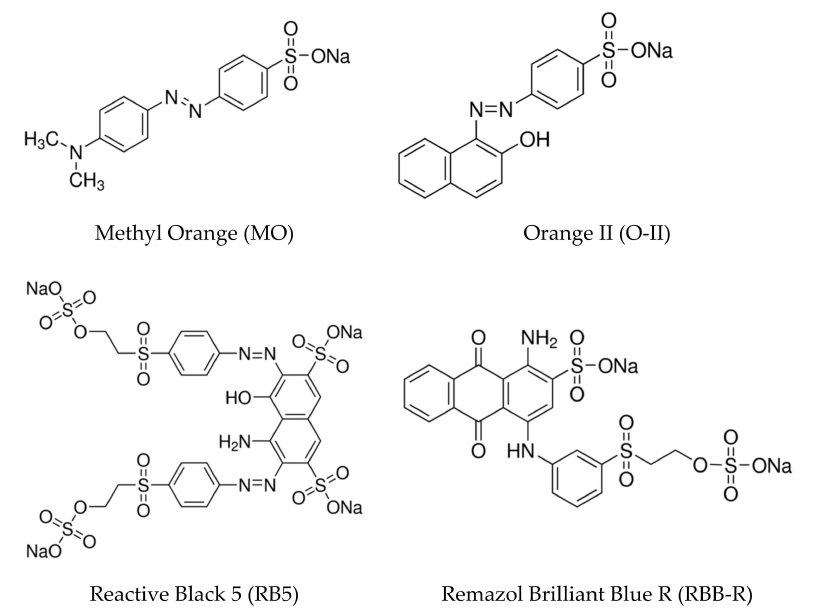
Figure 1. Chemical structures of the four dyes used in this work. MO, O-II and RB5 belong to the azo family of dyes, and RBB-R is an anthraquinone